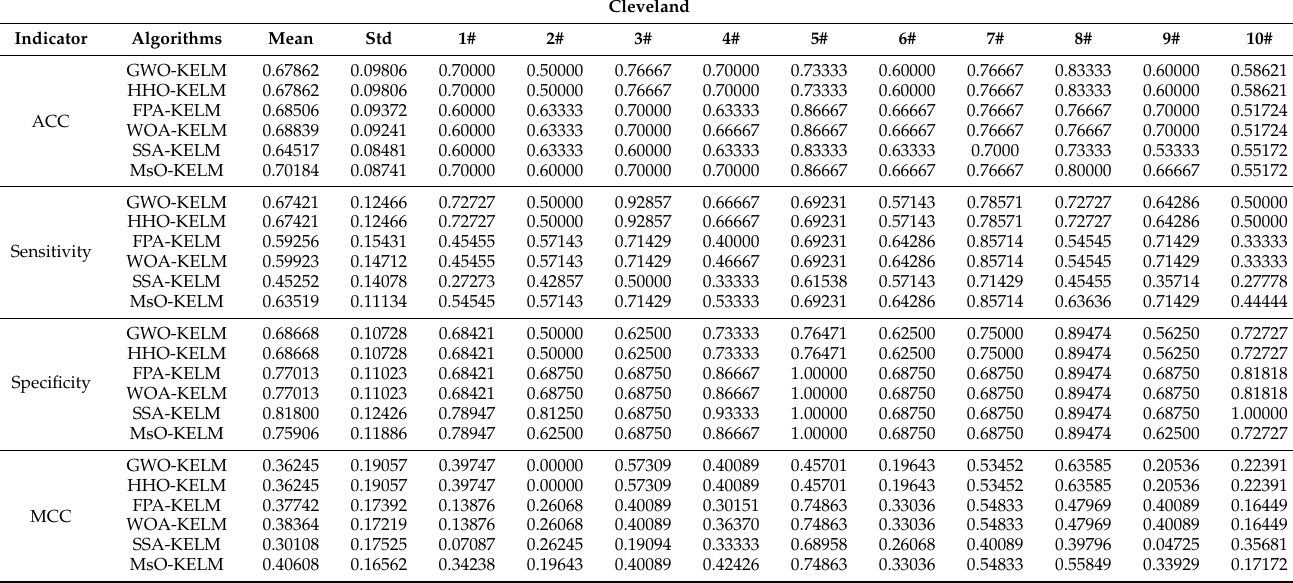
Table 10. The prediction results on disease dataset